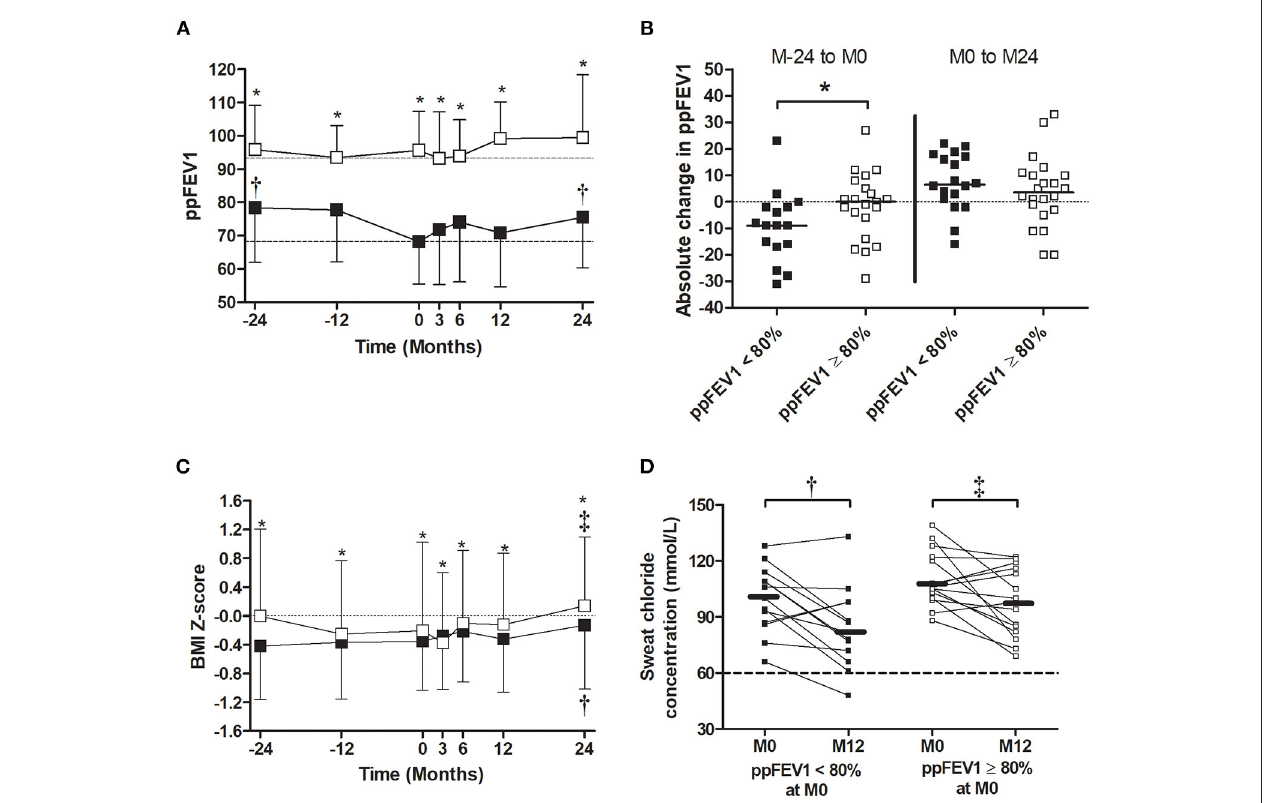
FIGURE 4 | Evolution of the percent predicted forced expiratory volume in 1s (ppFEV1), body mass index (BMI) Z -score, and sweat chloride before and after the initiation of lumacaftor/ivacaftor (LUM/IVA) in patient with or without ppFEV1 < 80%. Evolution of ppFEV1 (A) and BMI Z -score (C) 2 years prior (M-24) to 2 years after (M24) LUM/IVA initiation (M0) in patient with (black square) or without (empty square) ppFEV1 < 80%. Absolute changes of ppFEV1 between M-24 to M0 [ (B) left] and M0 to M24 [ (B) right]. Evolution of sweat chloride from M0 to M12 in patients with or without lung function (D) . Comparisons with data obtained at M0 were performed using the Wilcoxon paired test (A,B,D) and between the two groups using the Mann–Whitney test. *, † , and ‡ Indicate significant difference ( p < 0.05) compared with M0 in patients with ppFEV1 < 80% ( † ) and in patients with ppFEV1 ≥ 80% ( ‡ ) or between groups